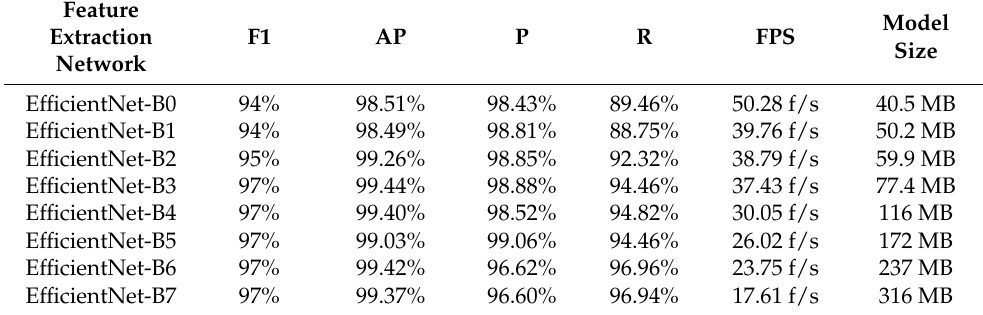
Table 3. Indicators related to each